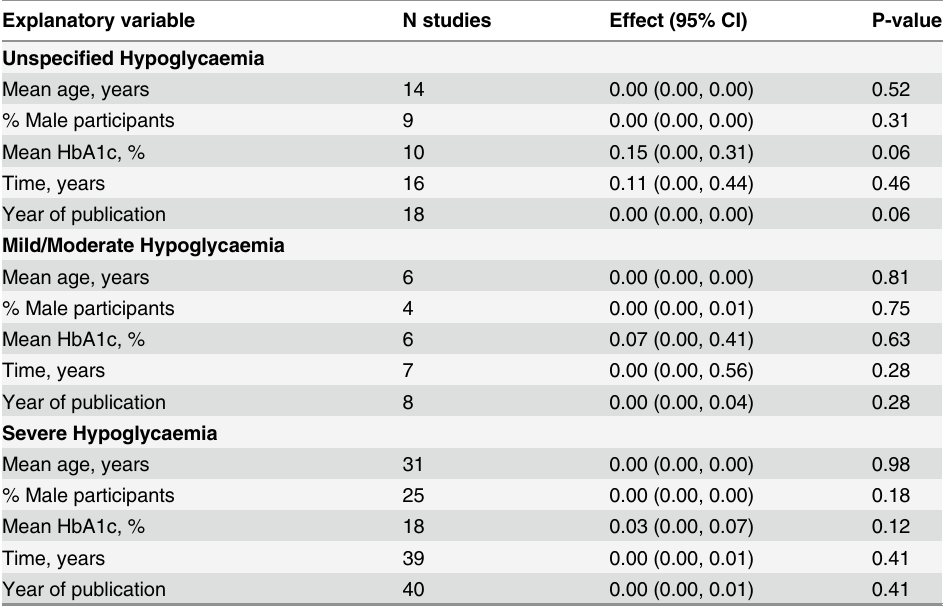
Table 3. Meta-regression results showing the effect of study-level variables on the proportion of peo- ple experiencing each severity of hypoglycaemia. Explanatory